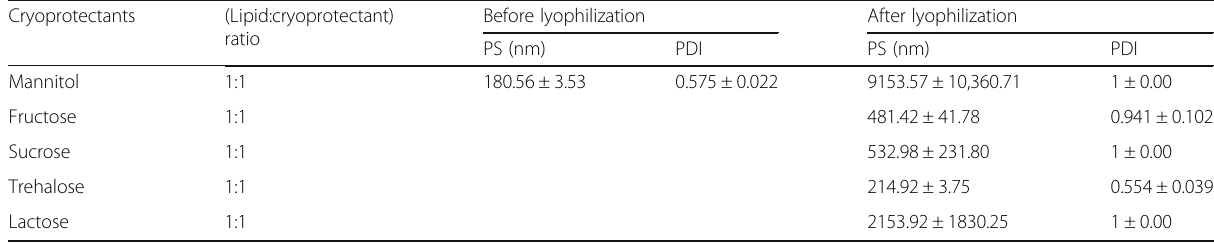
Table 3 Screening of different cryoprotectants on the basis of mean PS and PDI Cryoprotectants (Lipid:cryoprotectant) ratio